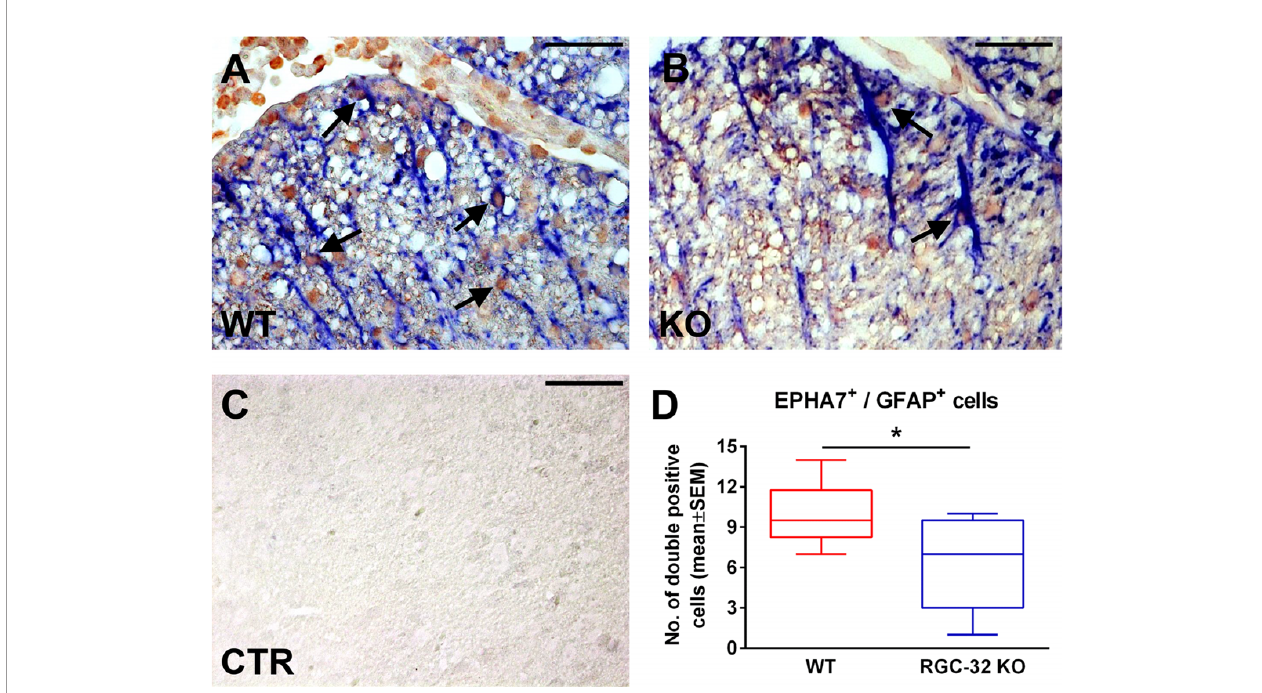
FIGURE 6 | RGC-32 is necessary for the expression of EPHA7 in reactive astrocytes at the peak of EAE. Cervical spinal cords were harvested from WT and RGC- 32 KO mice with EAE on day 14 and double-stained with anti-EPHA7 (red) and anti-GFAP (blue) antibody. We observed abundant EPHA7 co-localization with astrocytes in WT mice ( A , arrows), whereas in RGC-32 KO mice, EPHA7/GFAP double-positive cells were rare ( B , arrows). Controls (CTR) for the immunoperoxidase and AP reactions were negative (C) . Original magni fi cation: x40. Scale bars: 20 µm. When we counted the total number of EPHA7/GFAP-double positive cells per microscopic fi eld, we noticed that the number in WT mice was statistically signi fi cantly higher than in RGC-32 KO mice (D) . Results in (D) are expressed as mean ± SEM. N = 4 mice (8 microscopic areas) in WT; n = 4 mice (9 microscopic areas) in RGC-32 KO. *p < 0.05 (Mann-Whitney